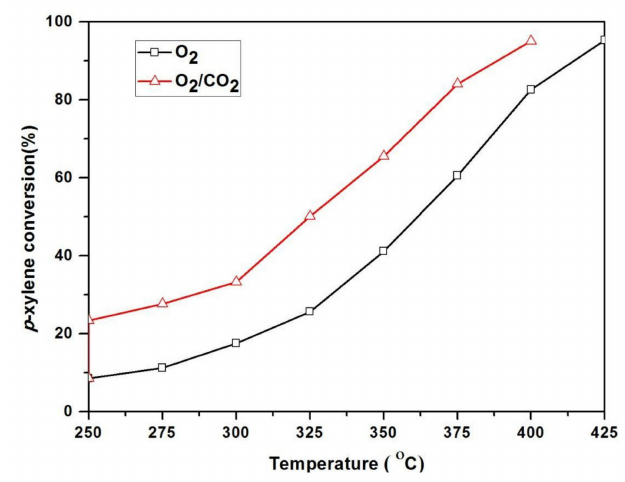
Figure 2. Promotional role of CO 2 on Fe / Mo / DBH for the oxidation of p -xylene. Table 4. Enhancive e ff ect of CO 2 on oxidation of p -xylene (Reproduced from [20]; copyright (1993), Elsevier). Reaction conditions: WHSV: 0.22 h − 1 , contact time: 0.21 s, gas flowrate: 400 sccm, Feed gas